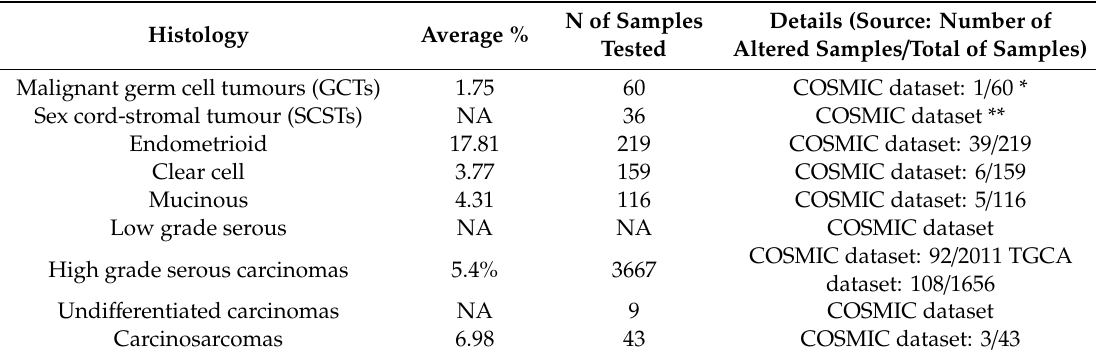
Table 1. Incidence of PTEN alterations in ovarian